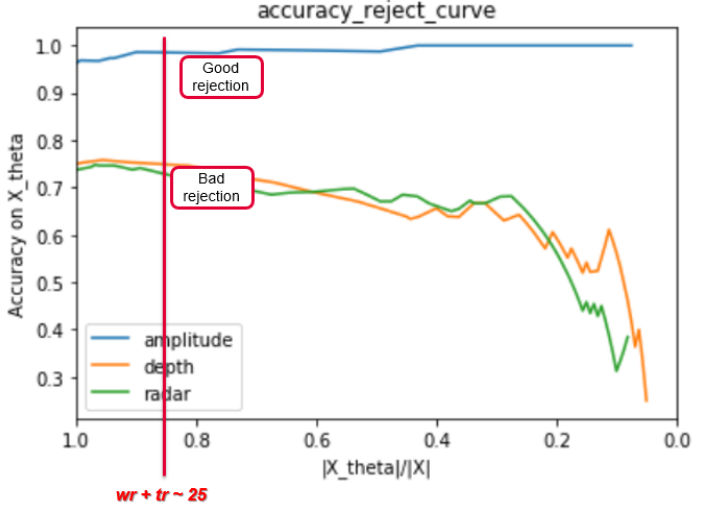
Figure 10. Accuracy reject curves presenting the accuracy of the three classifiers corresponding to the three considered sensors on the remaining data pints inside the validation data set after performing the classification with reject option